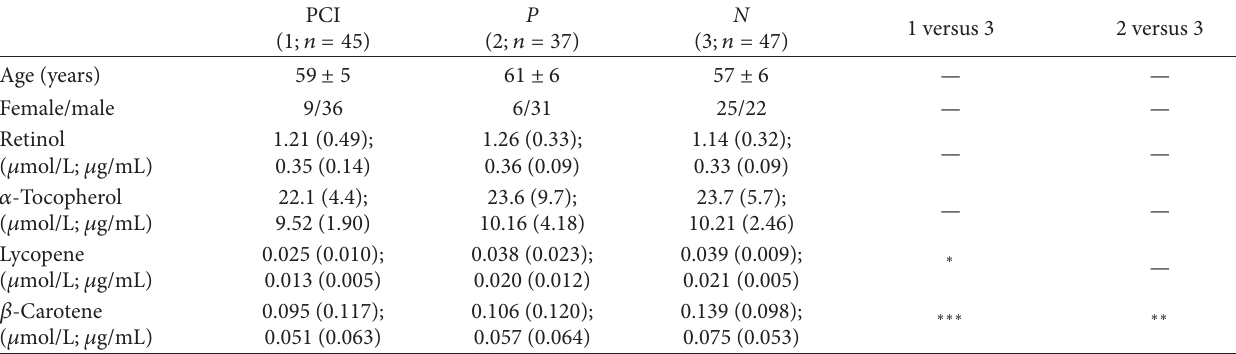
T 3: Comparison of levels of selected fat-soluble antioxidant vitamins between the patients and a control group.